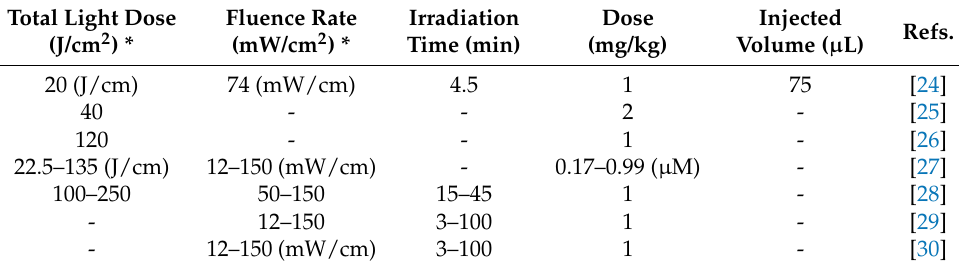
Table 1. Basic parameter values of in vivo verteporfin-PDT in